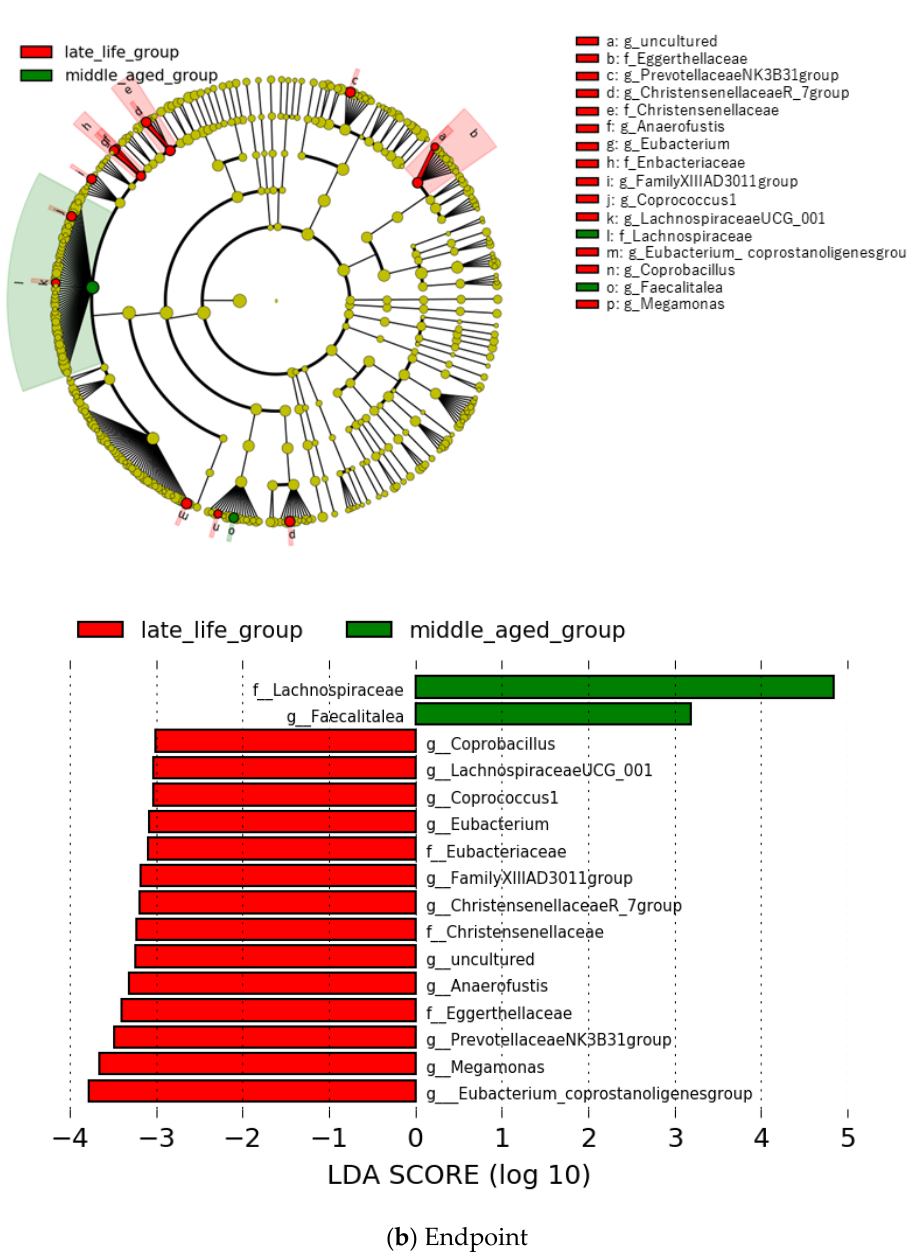
Figure 3. Specific bacterial contributor to the late-life (red) and middle-aged (green) groups by the LEfSe analysis (LDA >3.0) at genus level; Baseline ( a ), Endpoint ( b ). Notes: “f” = family level, “g” = genus level, “c” = class level, and “o” = order level.